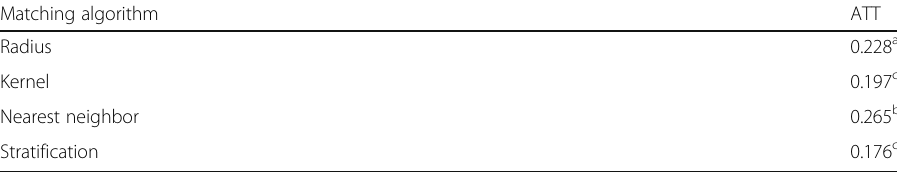
Table 3 Average treatment effect of cooperative membership under different algorithms Matching